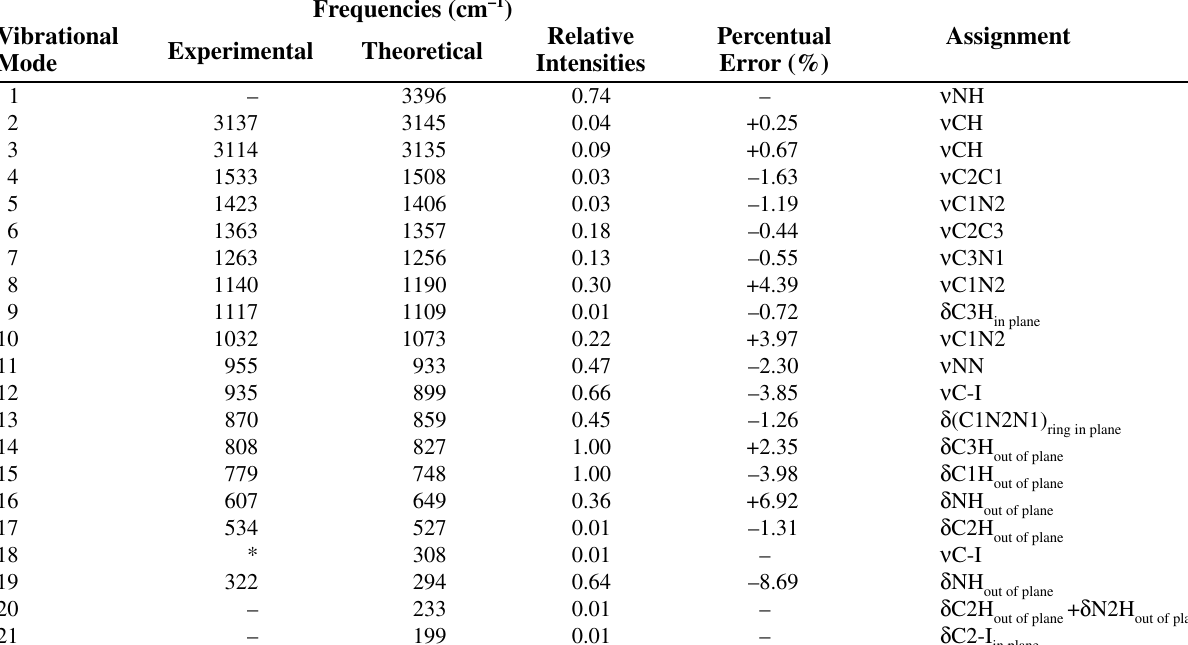
Table 3. Experimental and theoretical frequencies of 4-iodopyrazole (HIPz).